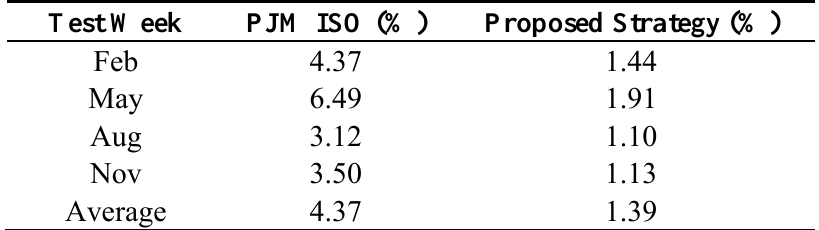
Table 3. Comparison of the STLF results of the proposed strategy with the STLF results of the PJM ISO for the four test weeks of year 2009 (the reported results are in terms of MAPE